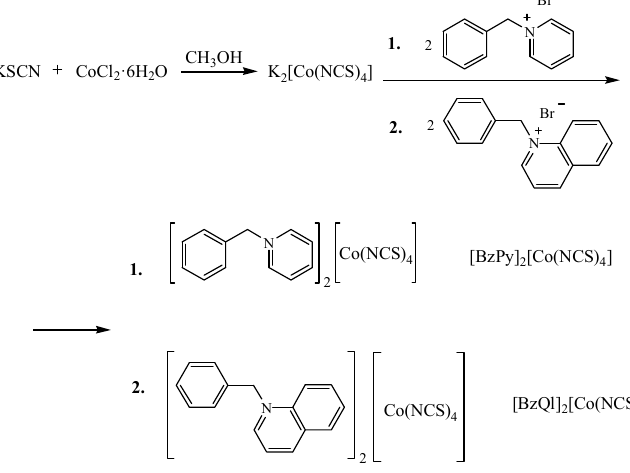
Figure 9. Synthetic route of the two complexes.